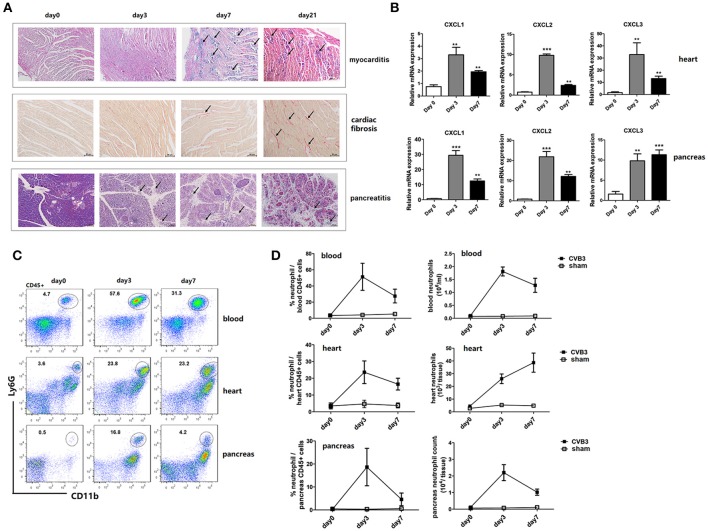
CVB3 infection induce an abundant recruitment of neutrophils into the heart and pancreas of mice. BALB/c mice were infected i.p. with 1500TCID50 CVB3 (5 mice/group). (A) H & E staining of the heart and pancreas sections showed the acute inflammatory myocarditis (arrows showing intra-cardiac immune infiltrates) and pancreatic destruction (arrows showing acinar cell lysis) during 0–7 days. Heart sections were also stained with sirius red to show cardiac fibrosis (arrows showing collagen deposition as positive for sirius red staining) during 0–21 days after infection. Scale bar: 100 μm (myocardis and fibrosis) and 50 μm (pancreas). (B) 0, 3, and 7 dpi, neutrophil chemokine expression in the heart or pancreas homogenates was measured by qPCR. (C) Representative flow cytometry plots of cardiac, pancreatic, and blood mononuclear cells stained with CD11b and Ly6G were shown. (D) Proportions and numbers of neutrophils were numerated in hearts, pancreas and blood of uninfected, d3 and d7 CVB3-infected mice. Results are presented as mean ± SEM, **p < 0.01; ***p < 0.001.